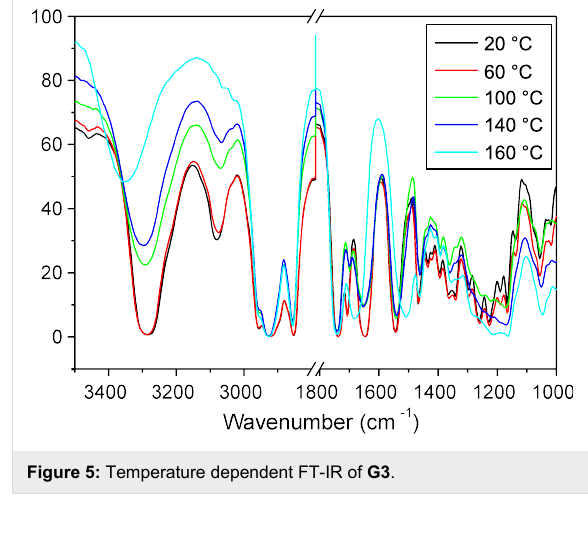
Figure 5: Temperature dependent FT-IR of G3 .